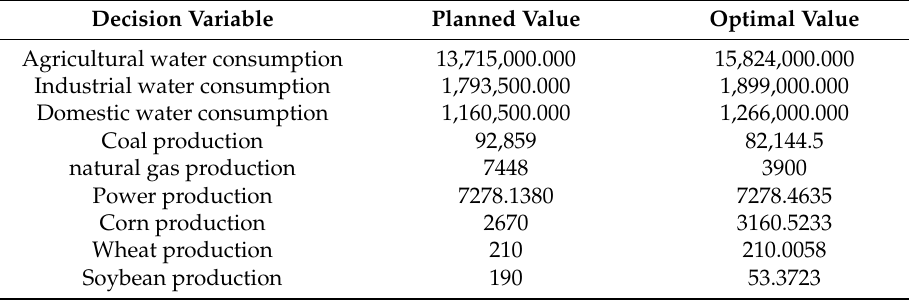
Figure 3. Comparison diagram of water consumption of different departments as well as different energy and food production in Inner Mongolia. Table 11. The planned value and optimal value of decision variable in 2020.